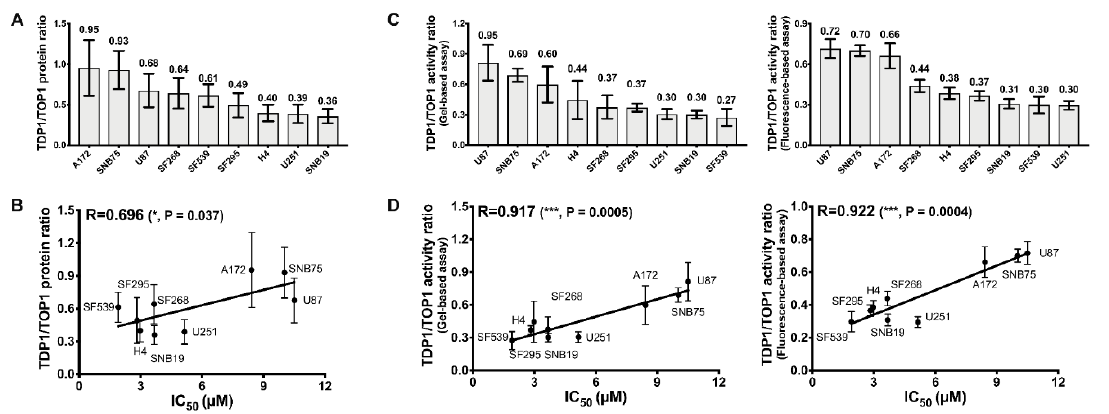
Figure 5. TDP1 / TOP1 activity ratio is a strong predictor for irinotecan IC 50 . ( A ) TDP1 / TOP1 protein Figure 5. TDP1/TOP1 activity ratio is a strong predictor for irinotecan IC 50 . ( A ) TDP1/TOP1 protein ratio levels and ( B ) Pearson correlation between the TDP1 / TOP1 protein ratio and irinotecan IC 50 for ratio levels and (B) Pearson correlation between the TDP1/TOP1 protein ratio and irinotecan IC 50 for GBM cell lines; ( C ) TDP1 / TOP1 activity ratio levels in GBM WCEs and ( D ) Pearson correlation between GBM cell lines; ( C ) TDP1/TOP1 activity ratio levels in GBM WCEs and ( D ) Pearson correlation irinotecan IC 50 and the TDP1 / TOP1 activity ratio based on TDP1 activity, measured by both gel-based between irinotecan IC 50 and the TDP1/TOP1 activity ratio based on TDP1 activity, measured by both and fluorescence-based gel-based and fluorescence-based assays.